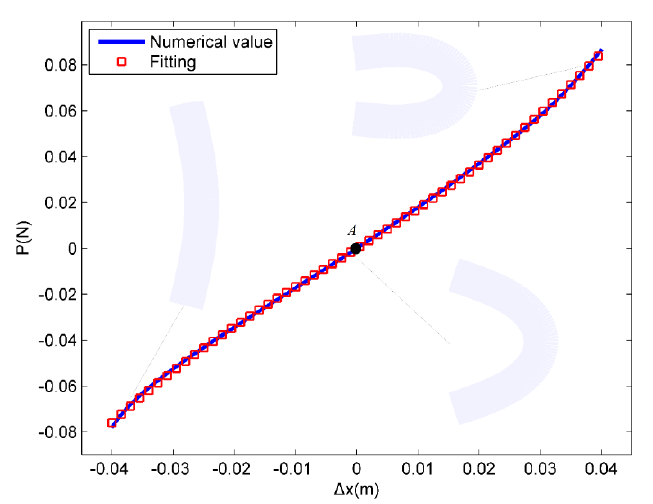
Figure 5. The numerical value of SGC’s recovery force curve and its fitting curve.